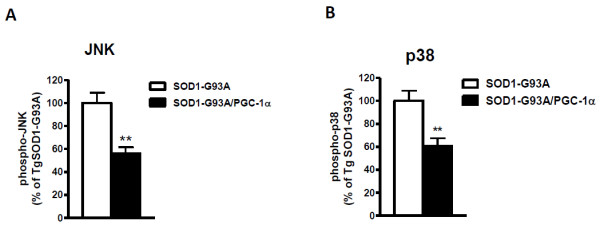
PGC-1α inhibited phosphorylation of JNK and p38 MAPK. Bead-based multiplex luminex assay was performed to examine the phosphorylation of (A) JNK and (B) p38 MAPK. Mean fluorescence intensities were recorded and data were plotted as percentage of SOD1-G93A animals (*p < 0.01).